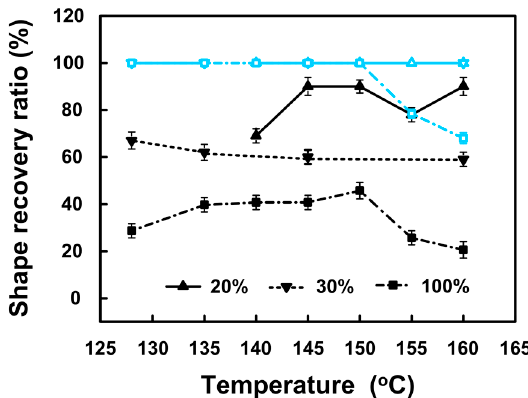
Figure 10. Shape recovery ratio ( R r ) as a function of the programming temperature and programming strain. Black line: upon heating to the programming temperature; blue line: upon further heating to180 °C.